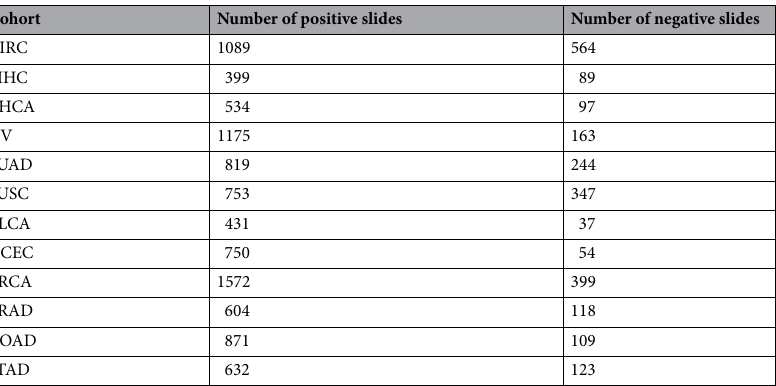
Table 1. The Cancer Genome Atlas (TCGA) cohorts and the number of frozen slide images used in the study. The slides with sample type codes 01 (primary solid tumor) and 11 (solid tissue normal) are referred to as positive and negative slides, respectively. Cohort abbreviations are as follows: KIRC kidney renal clear cell carcinoma, LIHC liver hepatocellular carcinoma, THCA thyroid carcinoma, OV ovarian serous